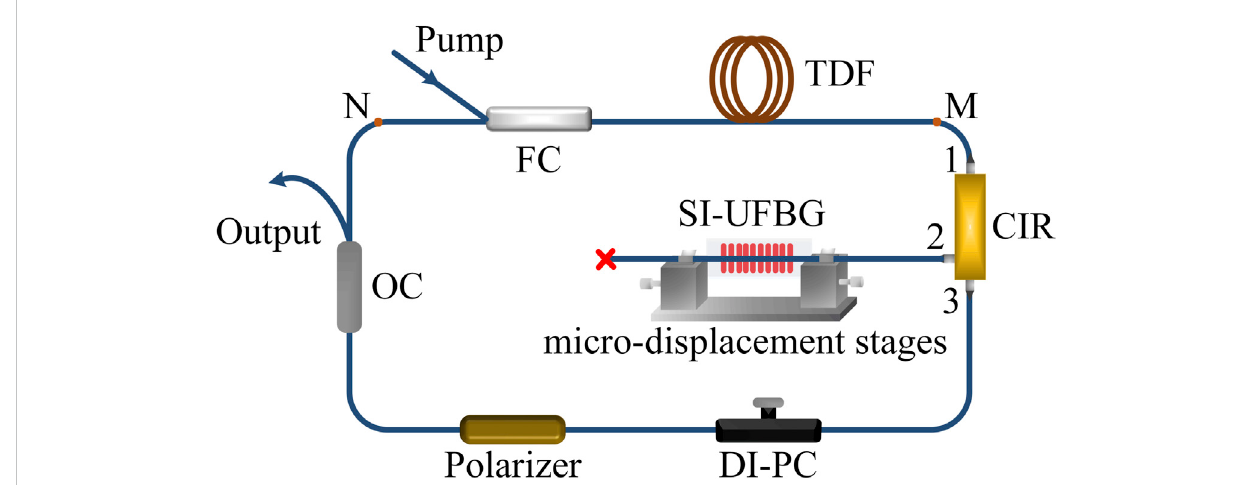
FIGURE 1 SchematicdiagramoftheTDFL.FC: fi bercombiner;TDF:thulium-doped fi ber;CIR:circulator;SI-UFBG:superimposed-uniform fi berBragggrating; DI-PC: drop-in-polarization controller; OC: optical